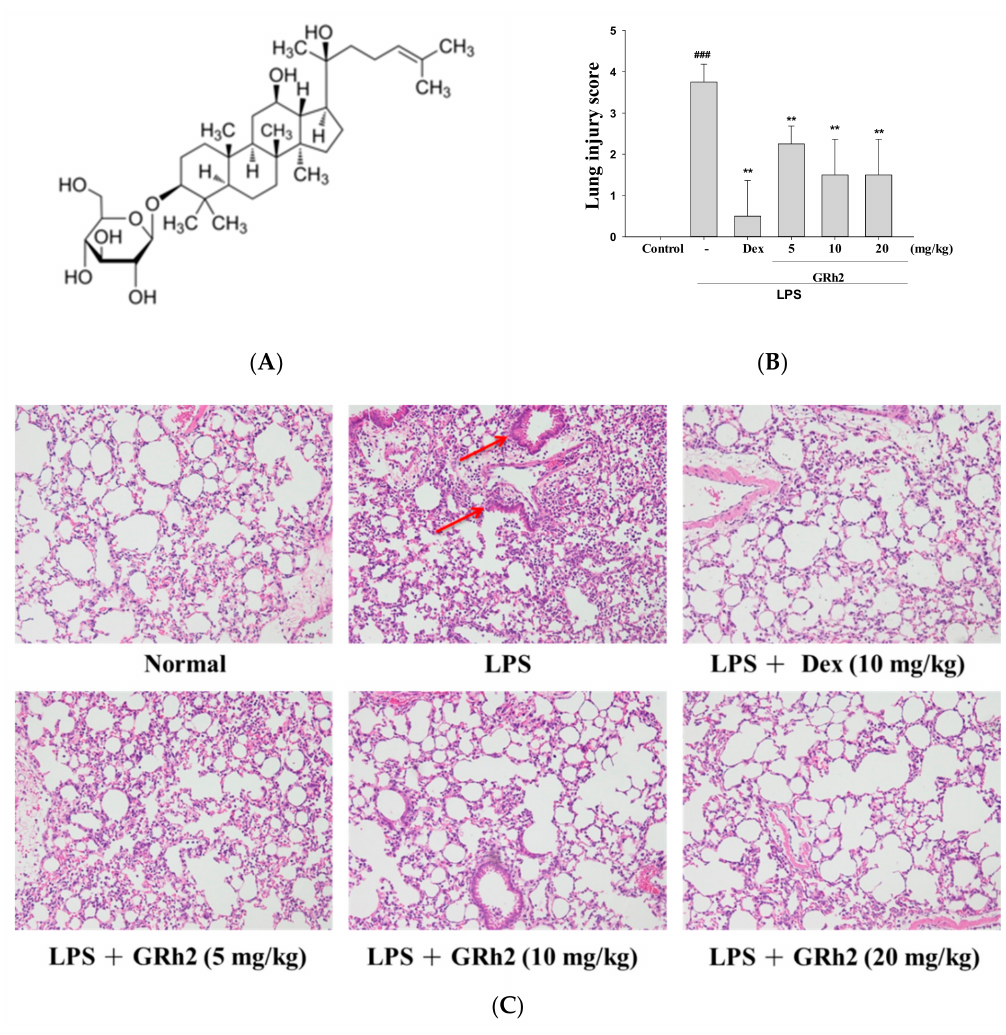
Figure 1. ( A ) The chemical structure of ginsenoside Rh2 (GRh2); ( B ) the lung-injury scores were determined; and ( C ) the effects of GRh2 (5, 10, and 20 mg/mL) on lipopolysaccharide (LPS)-induced lung histopathologic changes in mice. At 6 h after LPS challenge, lungs in each group were prepared for histological evaluation. Representative histological section of the lungs was stained by hematoxylin and eosin (H and E) staining, magnification (400 × ). The data are presented as the means ± S.E.M (n = 5). ### denotes p < 0.001 compared with sample of control group. ** p < 0.01 compared with the LPS-alone group. The red arrow indicates the symptoms of bleeding and inflammatory cell infiltration. Dexamethasone